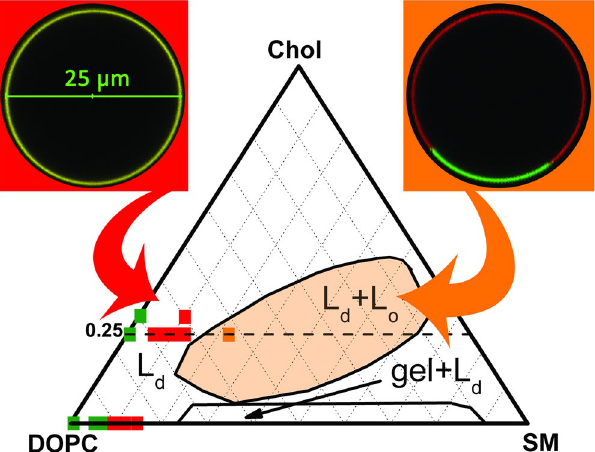
Figure 2. The DOPC/Chol/SM ternary phase diagram. The boundaries for the L d /L o and gel/L d regions of phase coexistence were taken from refs 14 and 15. Selected points mark the compositions at which homogeneous bilayers (green squares), bilayers with liquid-disordered (L d ) nanodomains (red squares) or with microscopic liquid-ordered (L o ) phase domains (orange square) were found. The fluorescent microscopy images at the top show the apparent homogeneous nature of the bilayers containing nanodomains and the microscopic heterogeneity of mixtures in the L d /L o phase coexistence region. The images were obtained by using g-GM 1 (green) and DiD (red) probes. The details concerning microscope setup are described in the Materials and Method section.